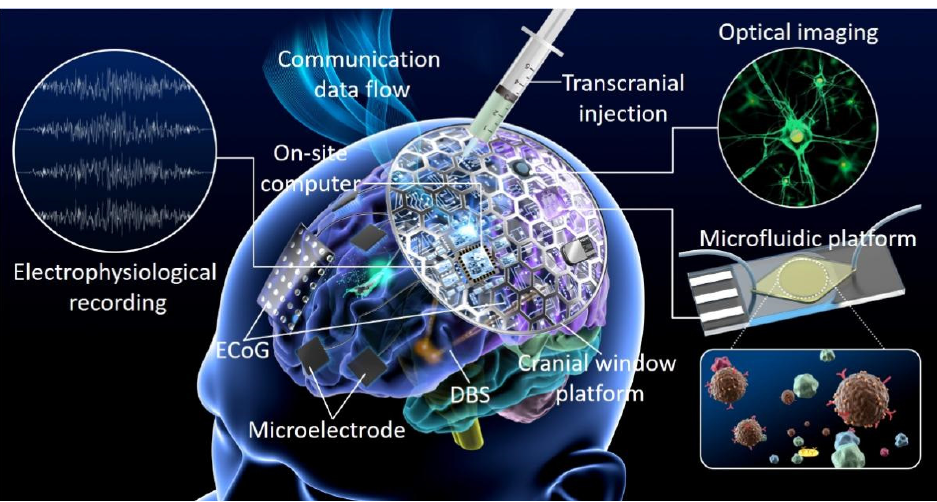
Figure 6. A proposal for a large-area multifunctional cranial window as a wearable smart electronic device for both medical and health care applications.